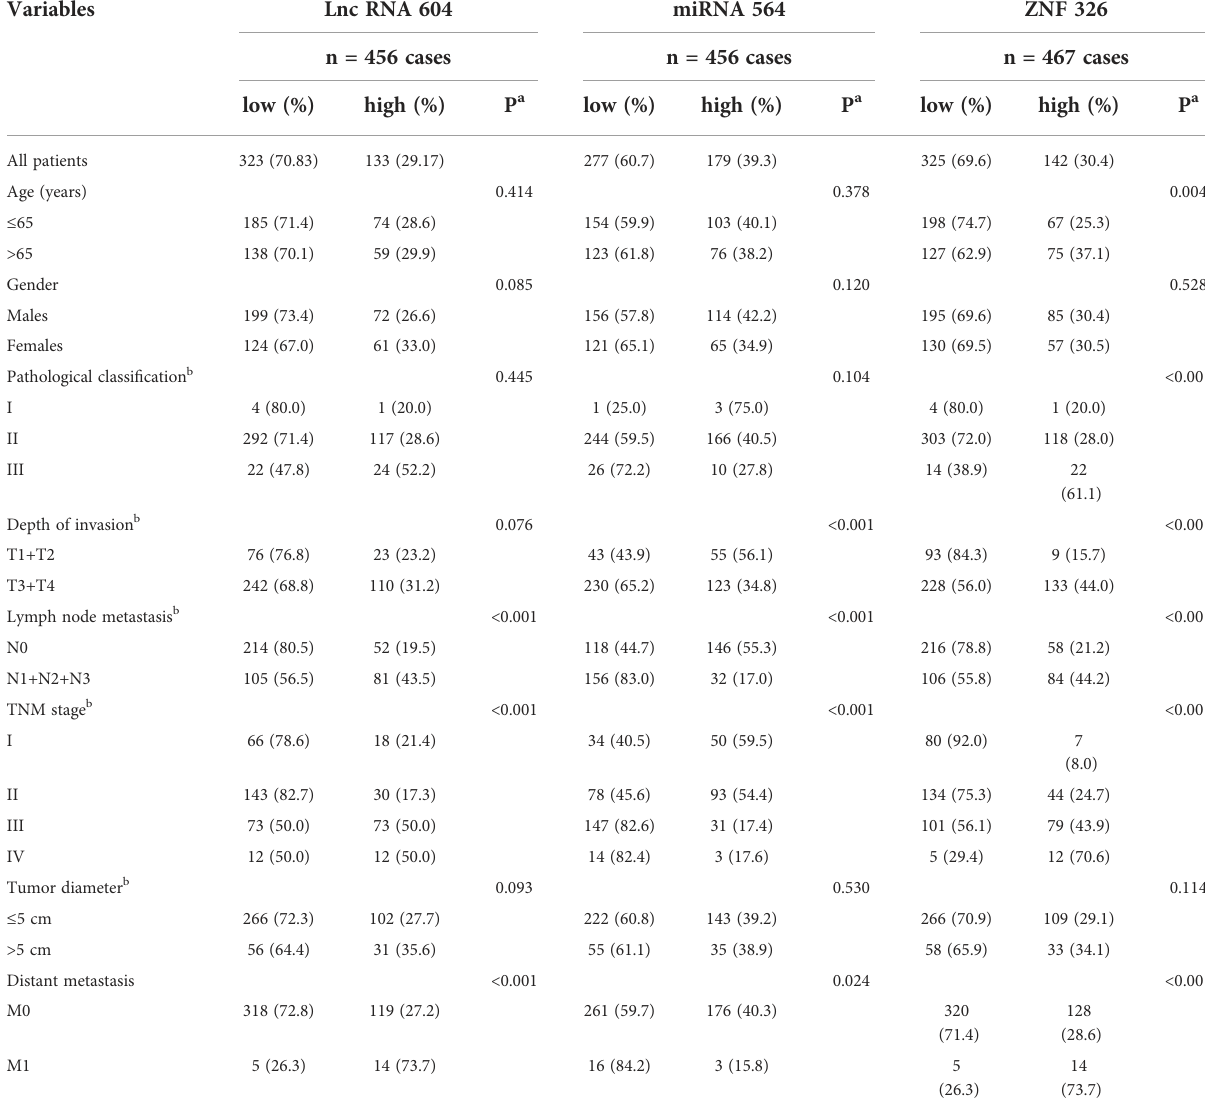
TABLE 1 Relationship between expression levels of Lnc RNA 604, miRNA 564, ZNF326 and clinicopathological features in CRC patients. Variables Lnc RNA